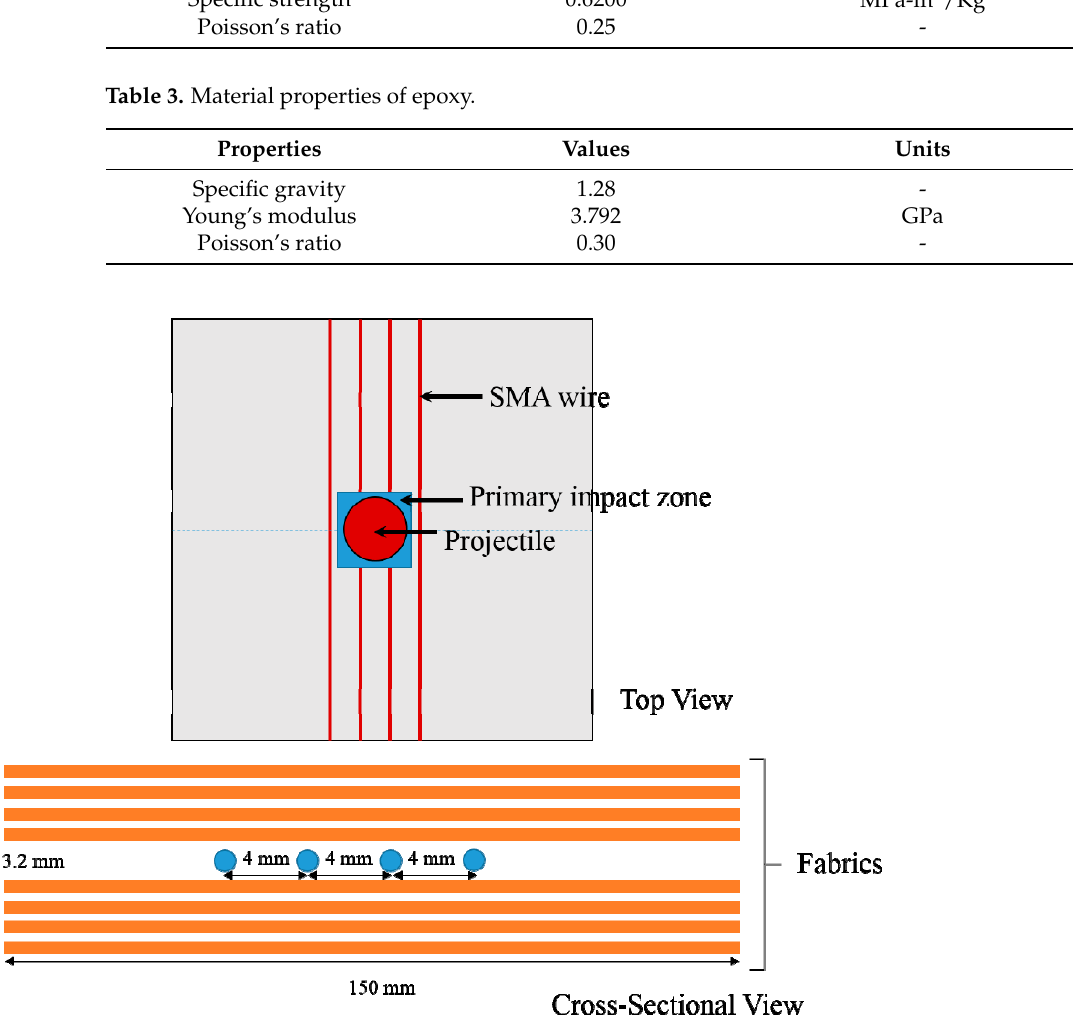
Table 2. Material properties of glass fibers. Properties